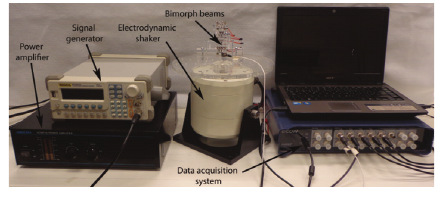
Figure 11: Experimental setup.